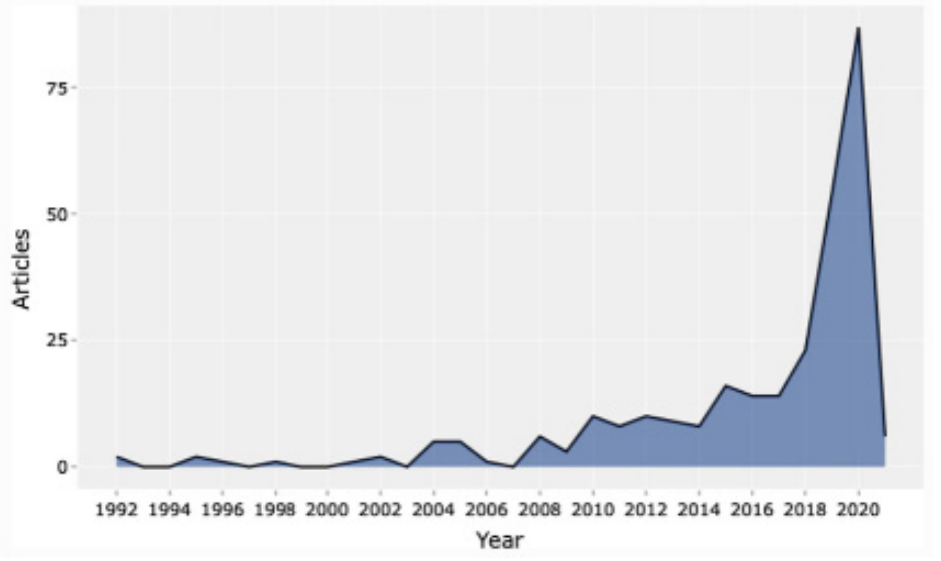
Figure 2. Articles published on artificial intelligence from 1992–2020 (permission to reproduce from Secinaro et al. [27]).